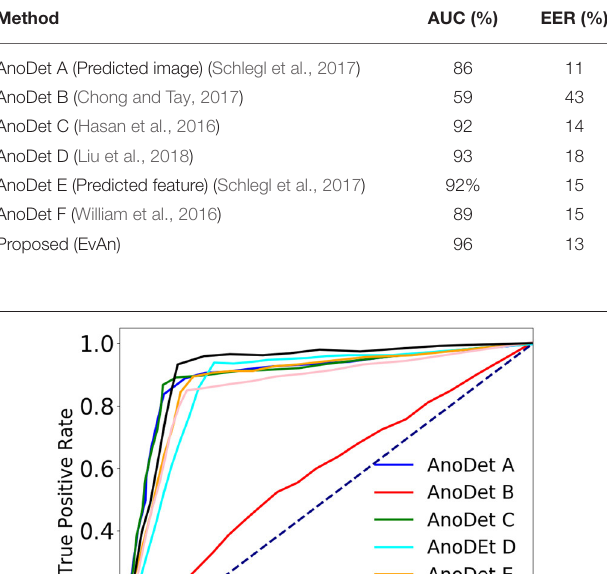
TABLE 6 | Comparison of the proposed anomaly network with state-of-the-art frame-based anomaly networks in terms of AUC and Equal Error Rate (EER). Dataset details are as mentioned in the previous sections.